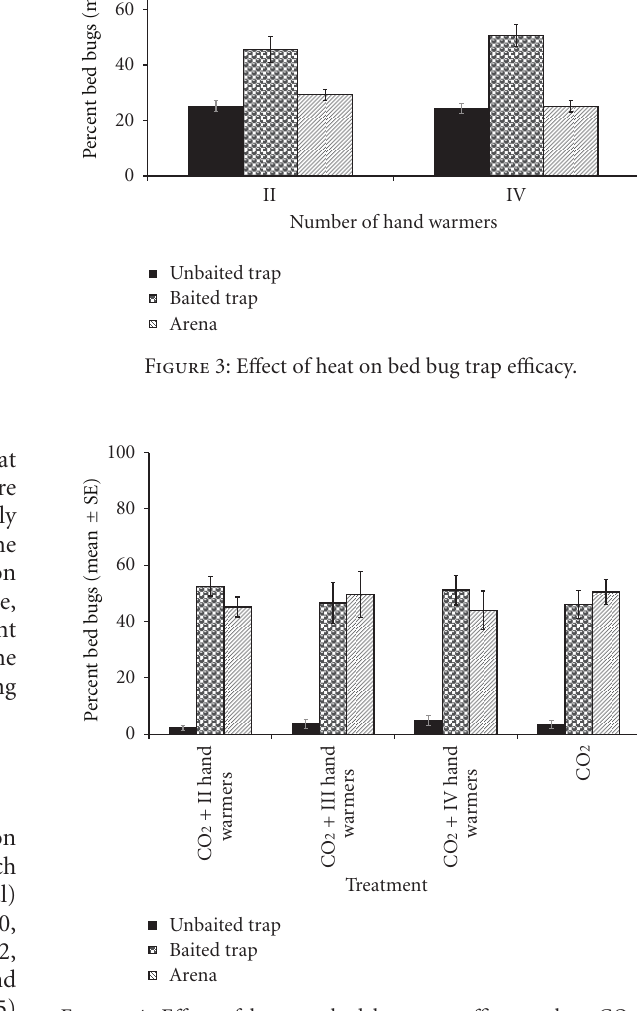
Figure 4: E ff ect of heat on bed bug trap e ffi cacy when CO 2 is